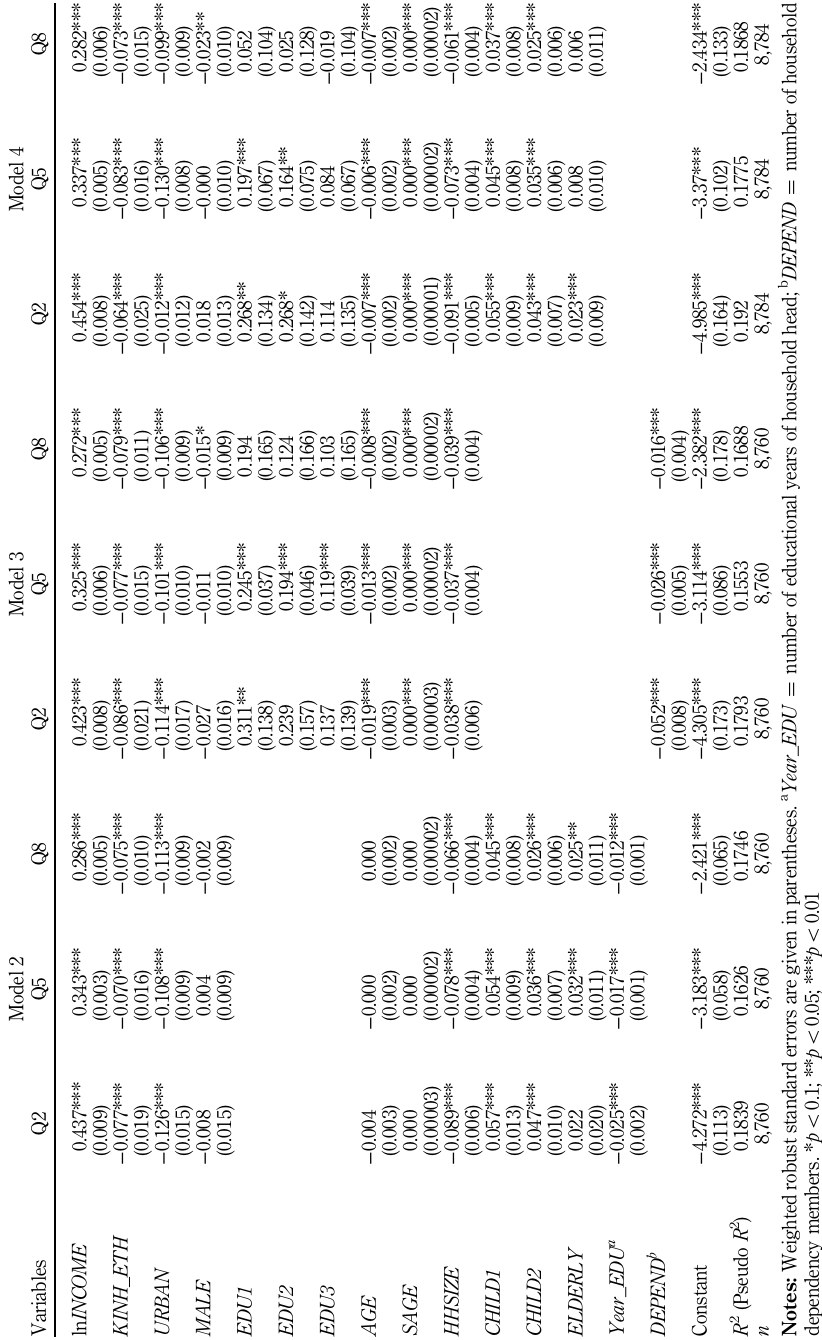
Table III. Robustness checks for the results of the quantile